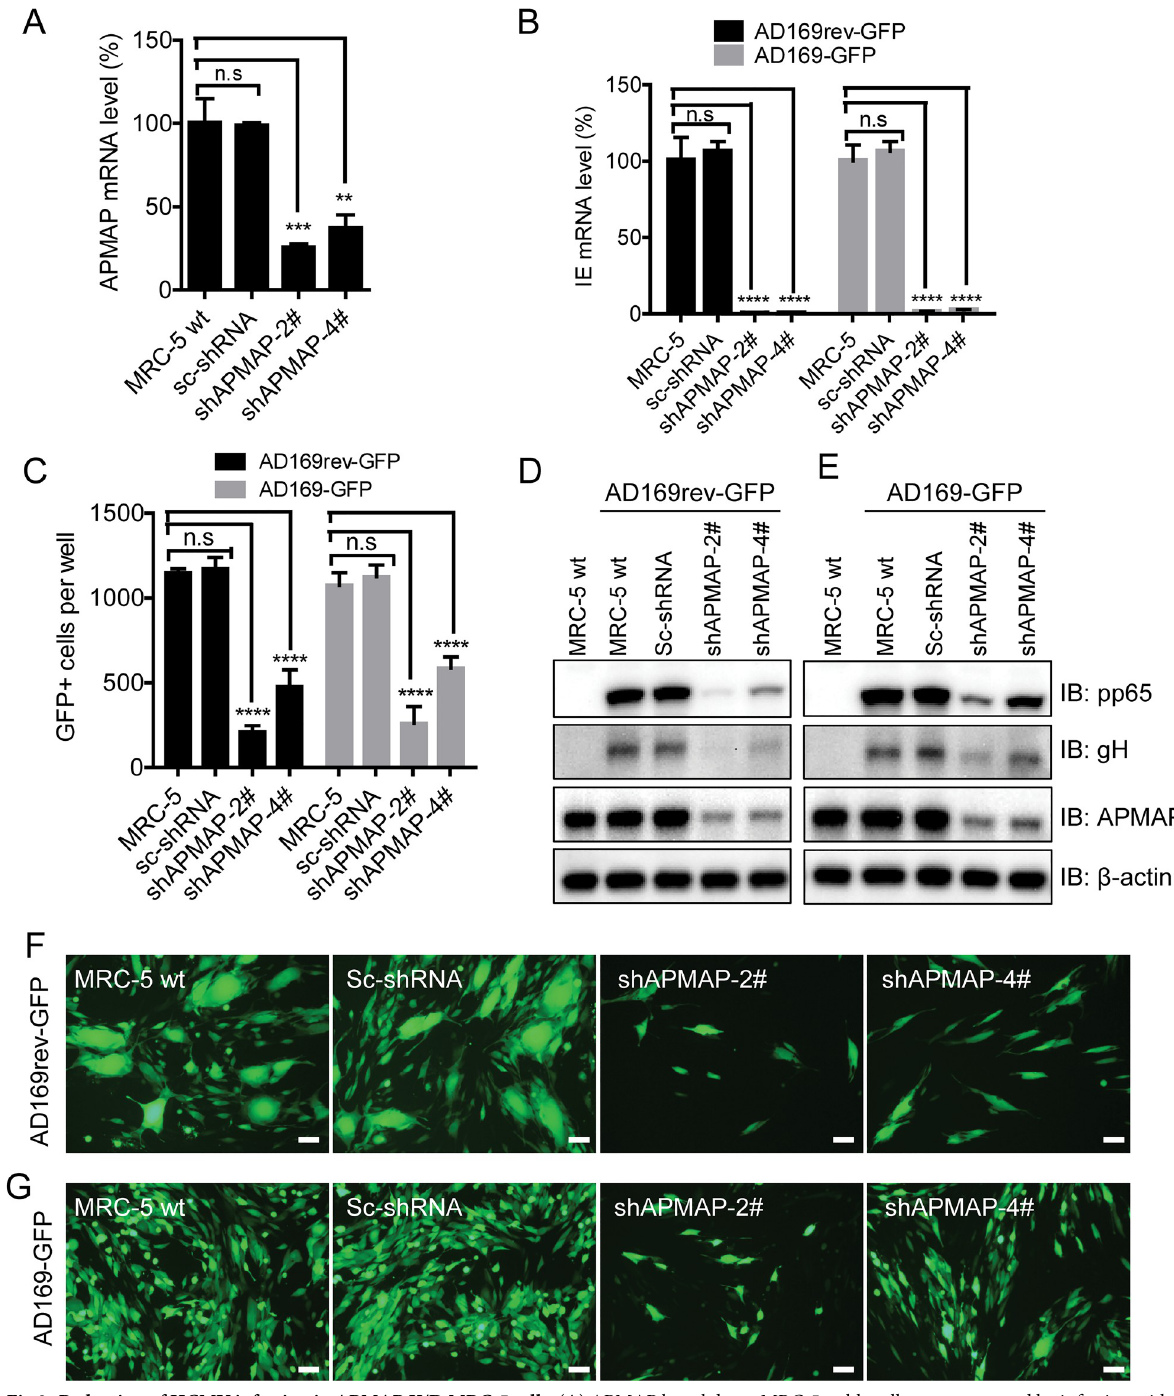
Fig 3. Reduction of HCMV infection in APMAP K/D MRC-5 cells. ( A ) APMAP knockdown MRC-5 stable cells were generated by infection with lentivirus expressing APMAP specific shRNA under puromycin selection. APMAP mRNA level in the knockdown cells were detected by RT-qPCR. GAPDH mRNA served as internal control. The data are shown as percentages of APMAP mRNA levels in knockdown cells relative to that of MRC- 5 cells. ( B ) Wildtype and APMAP K/D MRC-5 cells were infected with AD169rev-GFP and AD169-GFP at MOI = 1.0 in 96-well plate, respectively. 6 h after infection, the cells were collected for RNA extraction and RT-qPCR to detect viral IE mRNA level. The data were shown as percentages of IE mRNA level in infected knockdown cells relative to that of MRC-5 cells. GAPDH mRNA served as internal control. ( C-G ) In another HCMV infection experiment as in Fig 4B, ( C ) 48 h after infection, the plate was read by C.T.L. Immunospot machine to capture images under fluorescence cell mode for GFP. GFP positive cells in each well were counted automatically using the software. The data are shown as means ± SD of total number